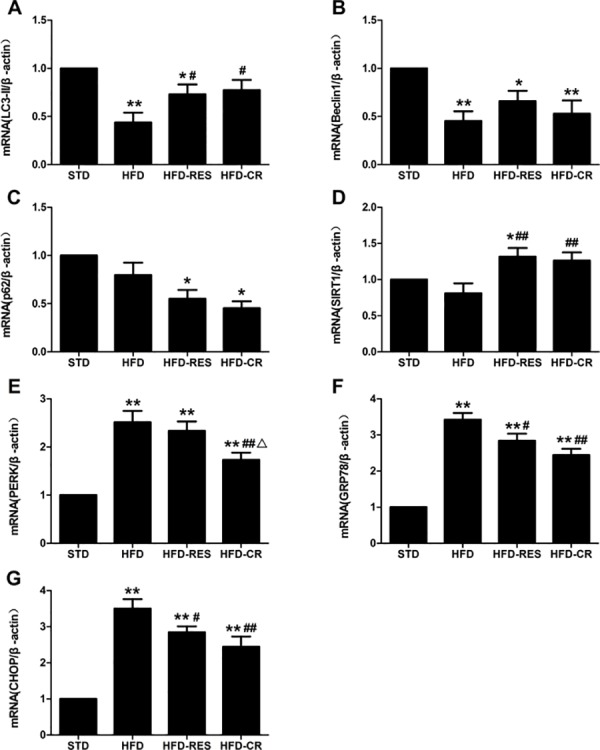
Changes of expression autophagy relative genes, ER stress genes and SIRT1 gene in the rat liver (n = 3 per group).(A) LC3. (B) Beclin 1. (C) p62. (D) SIRT1. (E) PERK. (F) GRP78. (G) CHOP. *, P<0.05 and **, P<0.01 compared with the STD group; #, P<0.05 and ##, P<0.01 compared with the HFD group; △, P<0.05 compared with the HFD-RES group. Data are expressed as the mean ± SD.